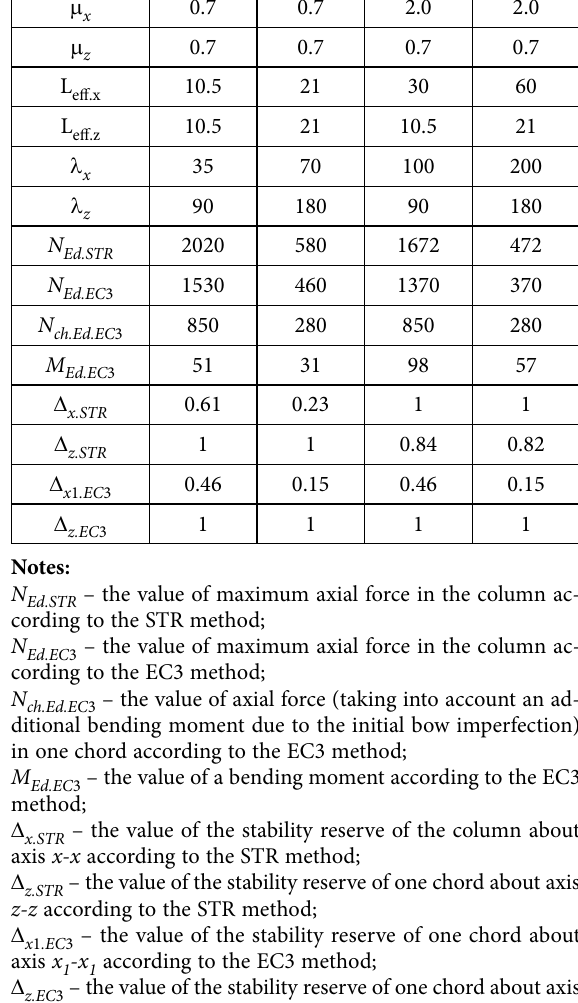
2 nd case: the column shape is perfectly straight, both chords are loaded by axial force N